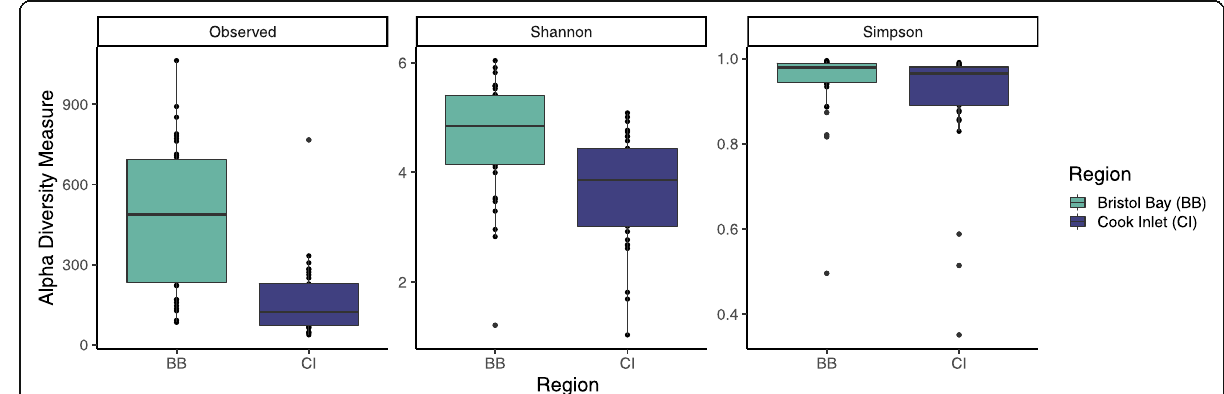
Fig. 1 Observed richness (number of ASVs), Shannon, and Simpson indices of alpha diversity among epidermal microbiomes in Bristol Bay (BB) and Cook Inlet (CI) beluga